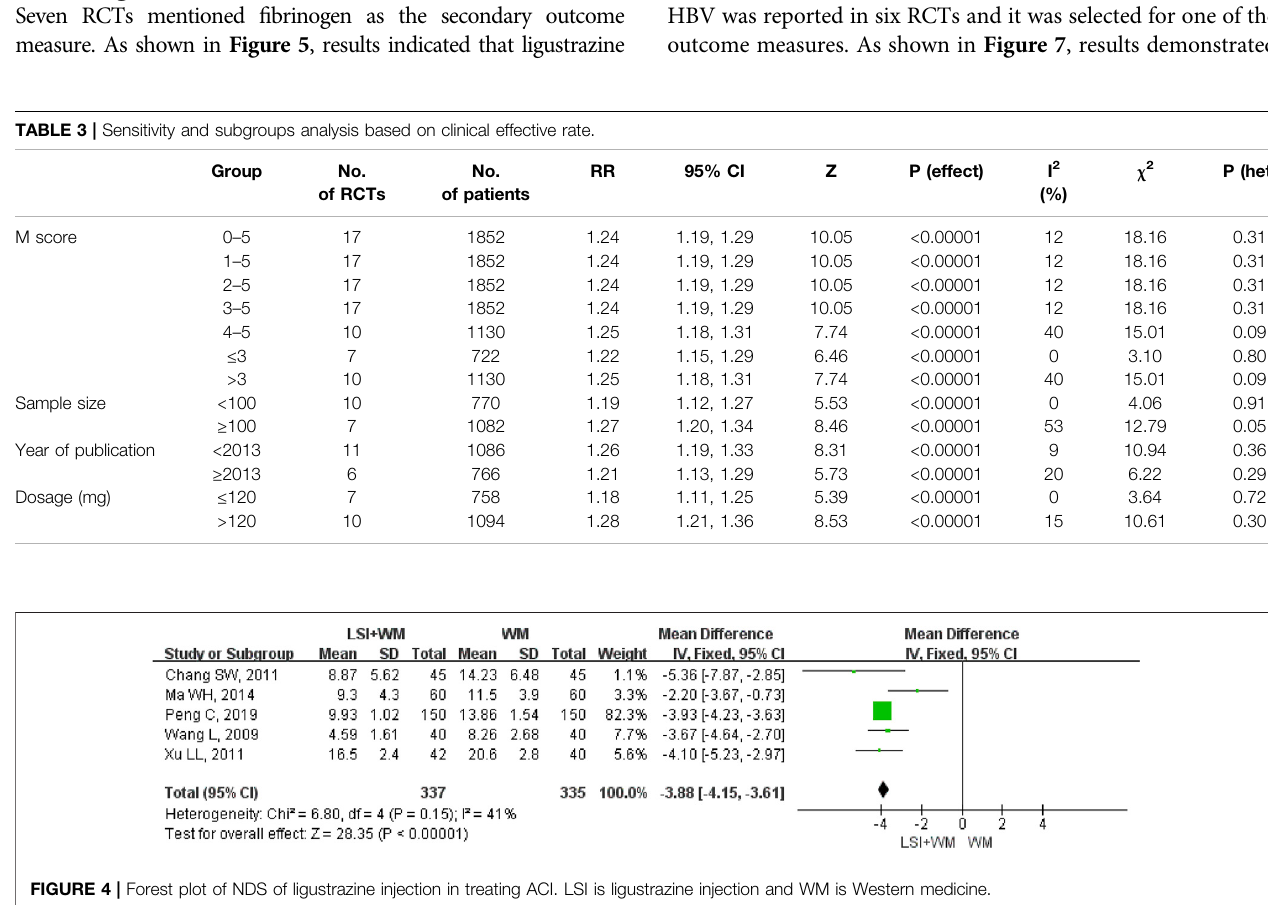
Frontiers in Pharmacology |